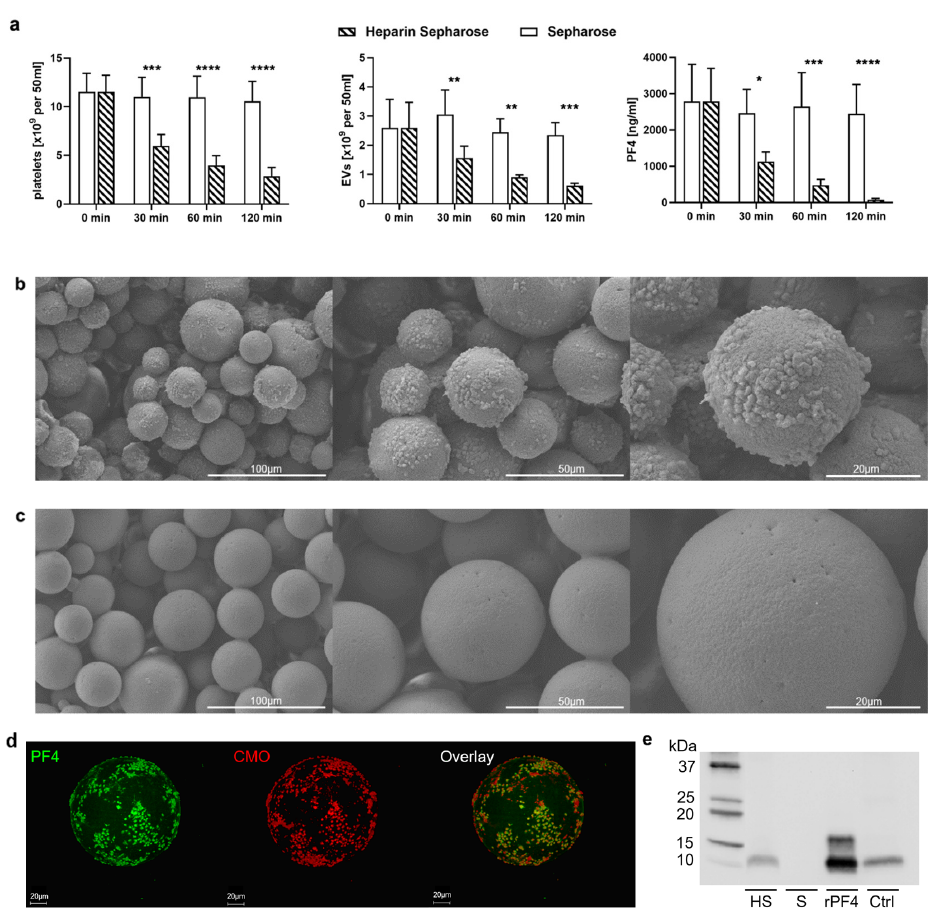
Heparin Sepharose beads stained positive for PF4 (Figure 3d), and the presence of PF4 on Heparin Sepharose was further confirmed by Western blotting of protein fractions eluted from the adsorbent beads (Figure 3e).